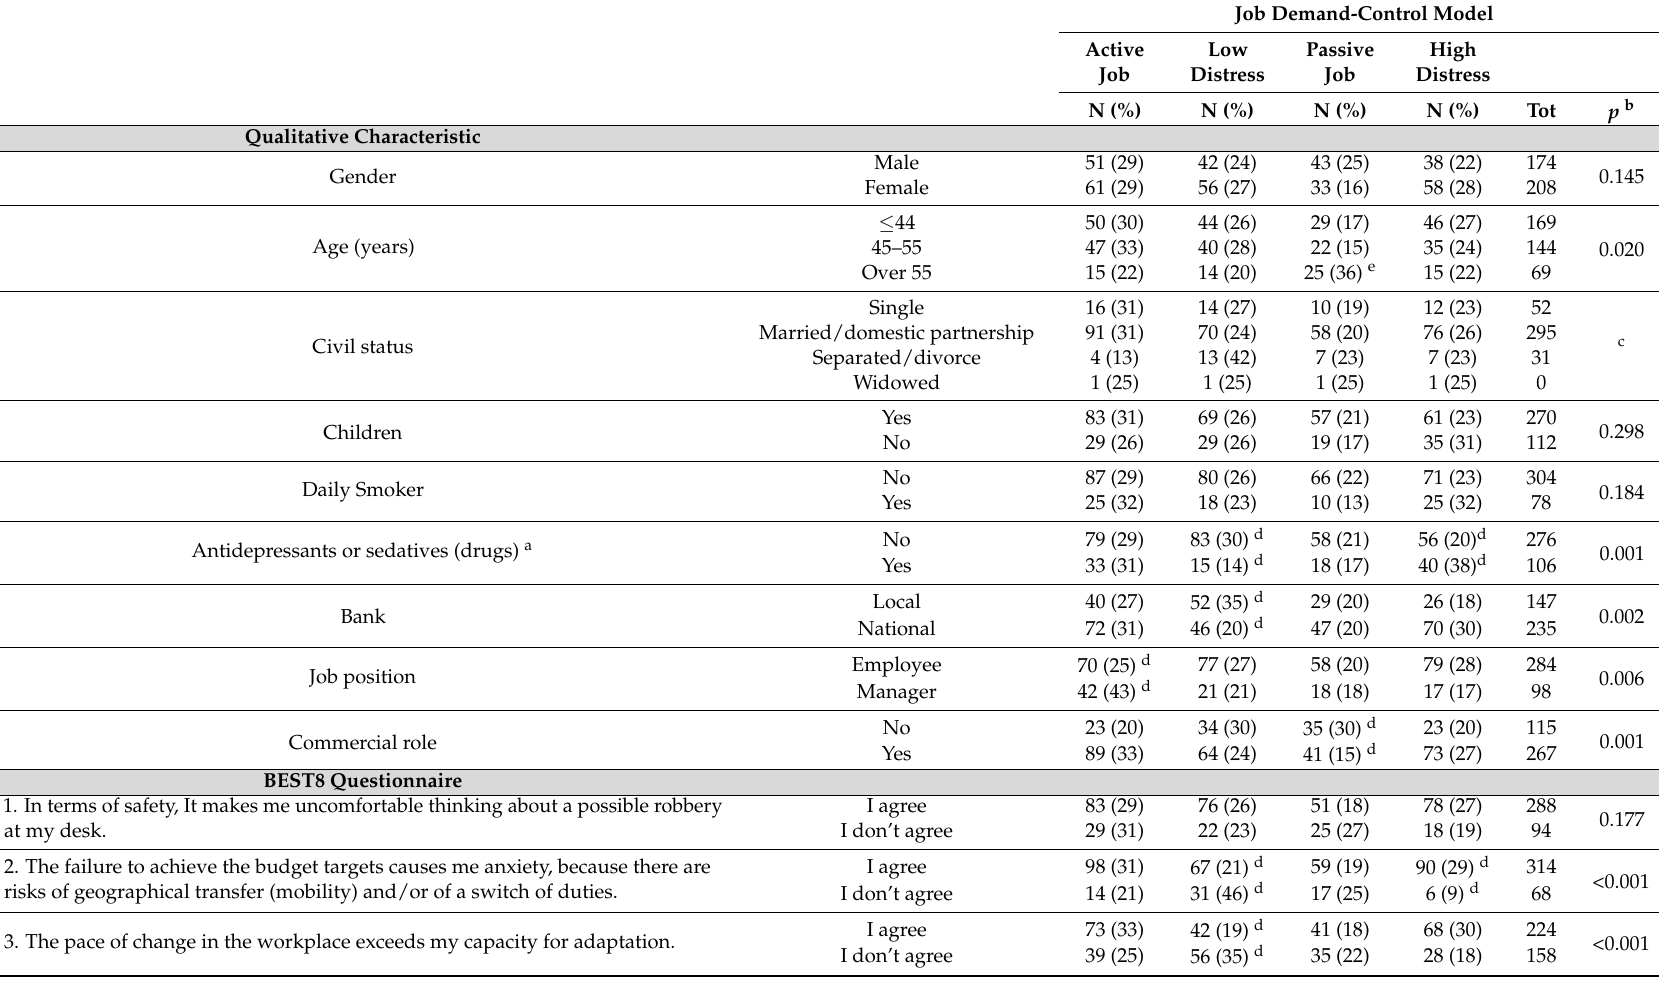
Table 2. Association between JDCM and demographic-job characteristics of the